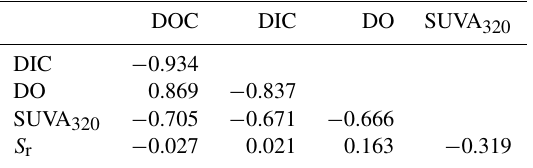
Table 3. Pearson correlations between the measured changes in the five metrics, namely DOC, DIC, DO, SUVA 320 , and S r . DOC DIC DO SUVA 320 DIC − 0.934 DO 0.869 − 0.837 SUVA 320 − 0.705 − 0.671 − 0.666 S r − 0.027 0.021 0.163 − 0.319